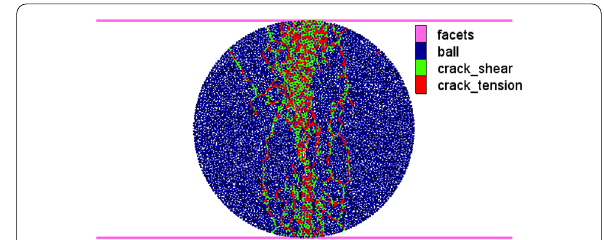
Fig. 14 Crack state when the water–cement rate was 0.5.